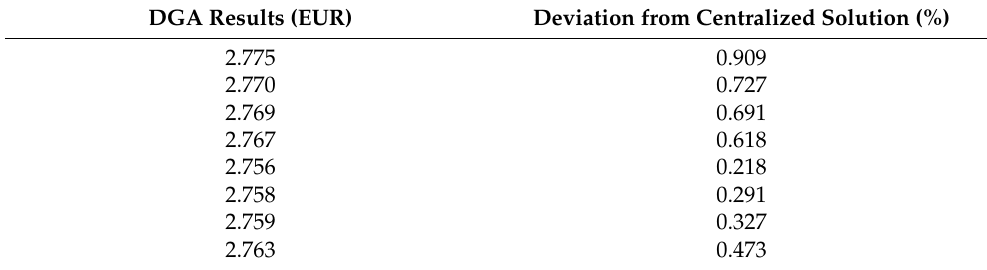
Table 4. Network branch data.